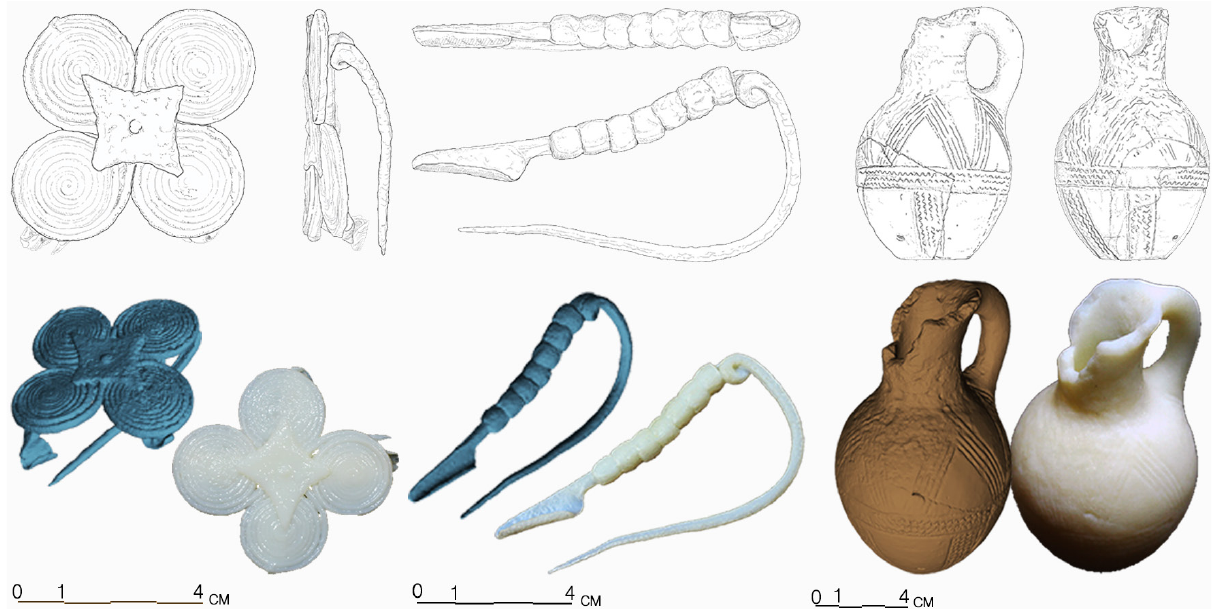
Figure 6. The archaeological artefacts belonging to the grave goods: 3D survey of the individual pieces, virtual models and prototypes.